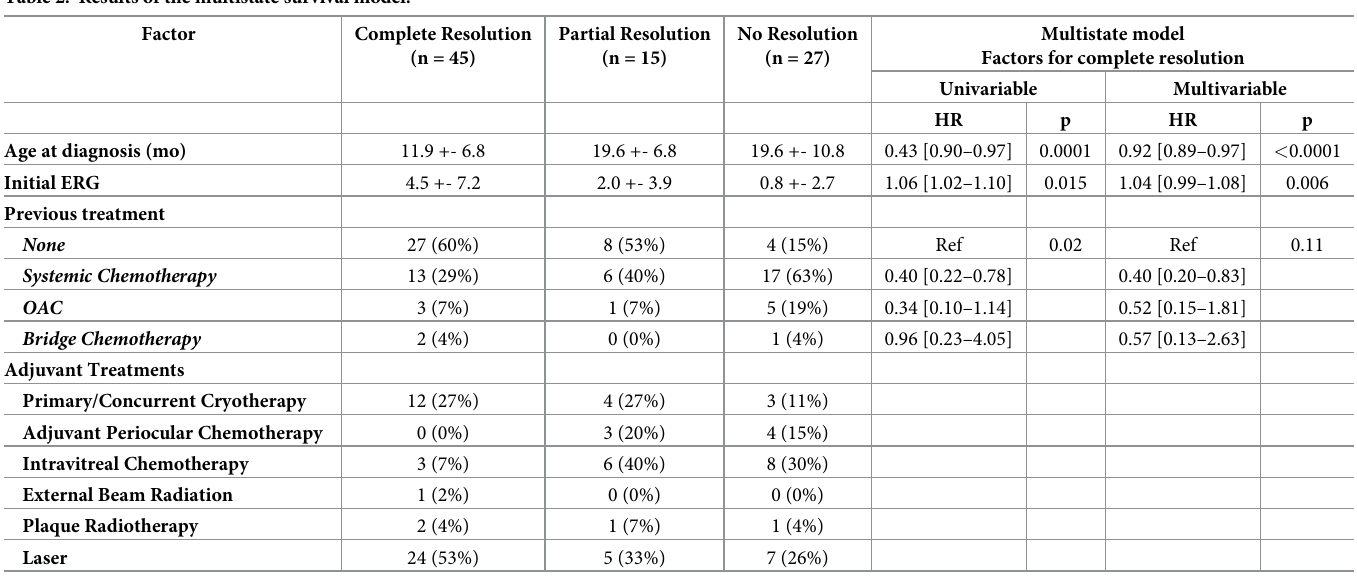
Table 2. Results of the multistate survival